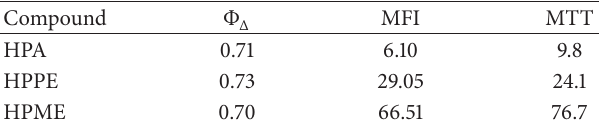
Table 3: Cellular affinity (MFI) and photodynamic tumoricidal effect (MTT) of